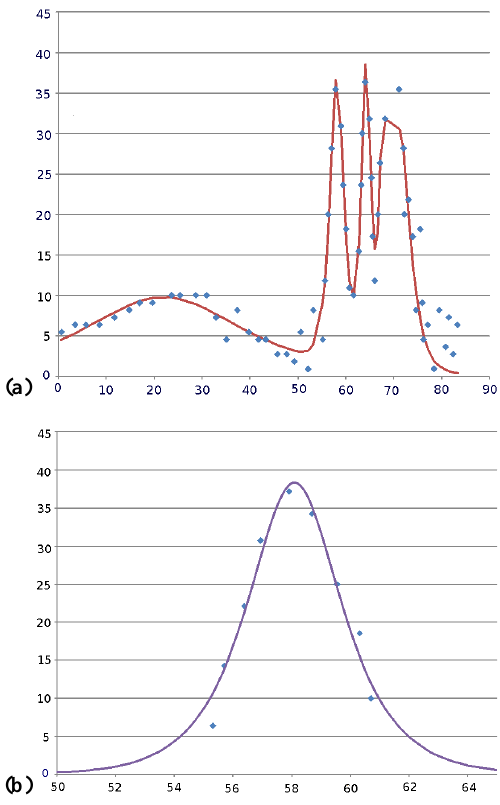
Fig. 2. (a) Single wave packet with the envelope approximated by N-soliton solution. (b) Smooth curve given by sch( t/ 1 . 18ms) cor- responds to the 2th